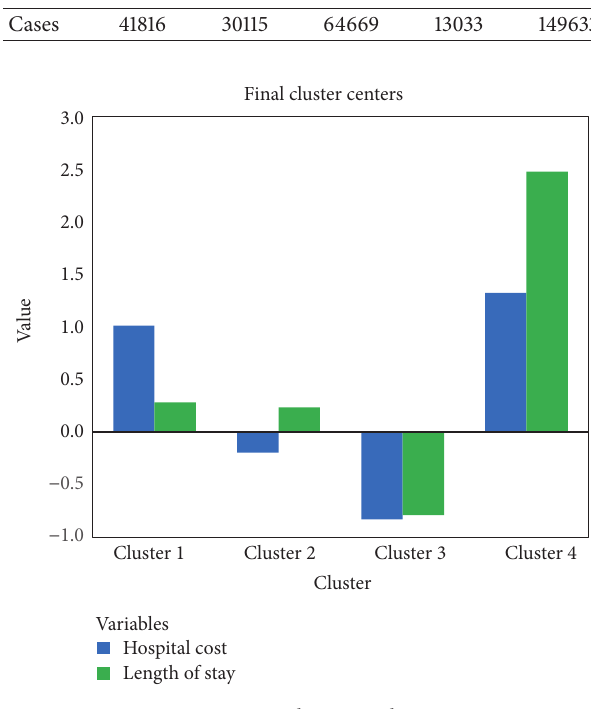
Figure 1: Cluster results.